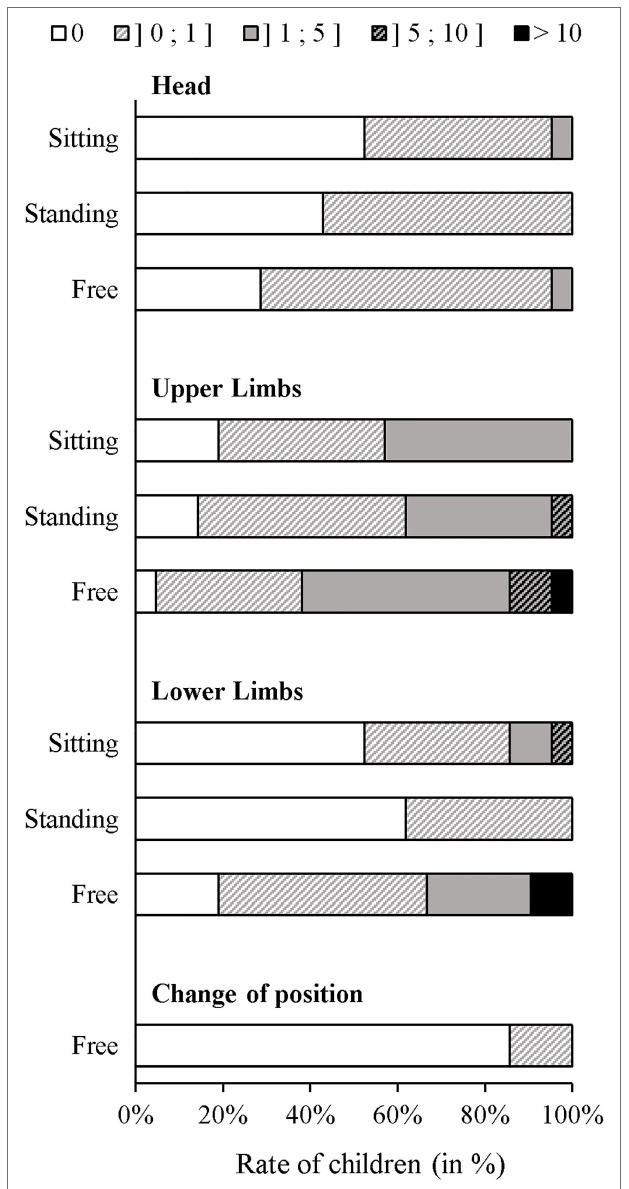
FIGURE 1 | Proportion of children not moving (0), moving between 0 and 1, 1 and 5, 5 and 10 and more than 10 s per minute for each type of movement in each body mobility